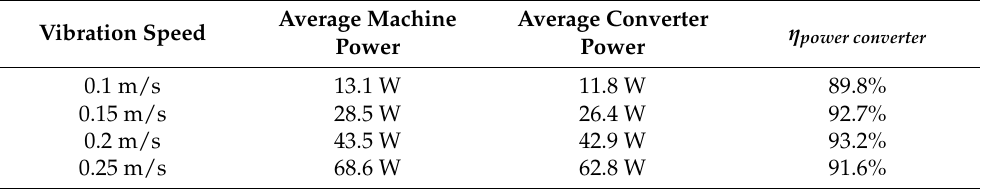
Table 3. Average power and efficiency of machine and converter